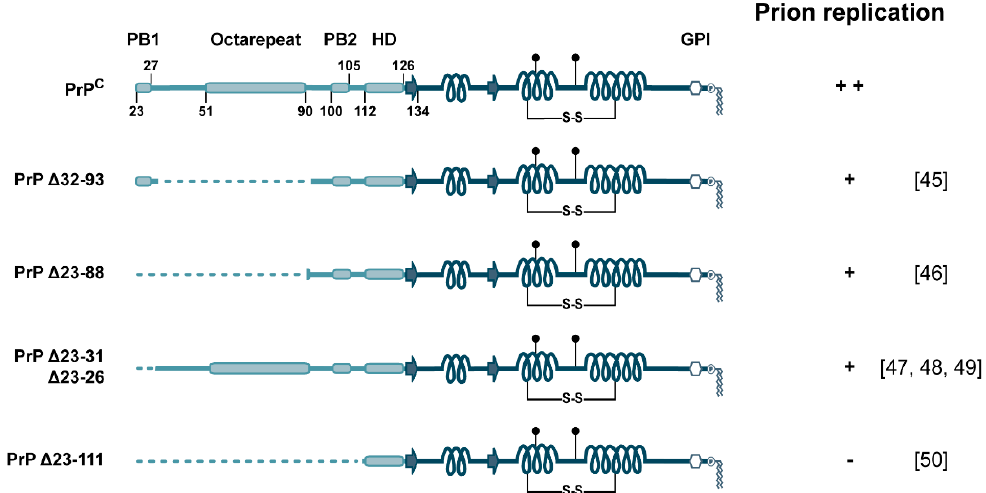
Figure 2. The role of the N-terminal domain in prion propagation. Schematic representation of PrP C variants and their ability to support replication of infectious prions in mice after inoculation with scrapie prions. The numbering of the residues refers to mouse PrP C . Respective publications are in brackets.